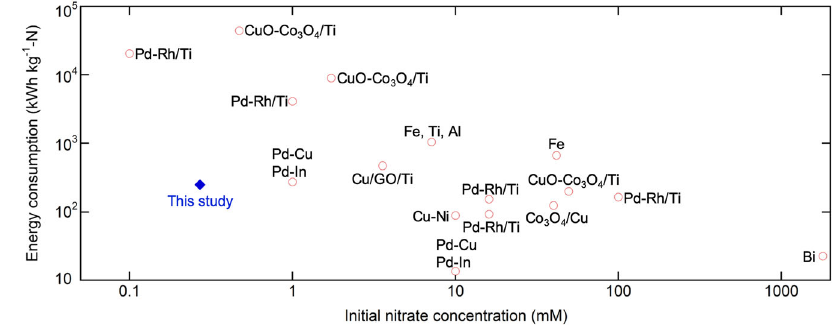
Fig. 8 | Energy consumption of reported electrochemical nitrate reduction studies. Starting nitrate concentrations and corresponding energy consumptions (kWhkg − 1 -N) in reported electrochemical nitrate reduction studies 20,29,47 – 53